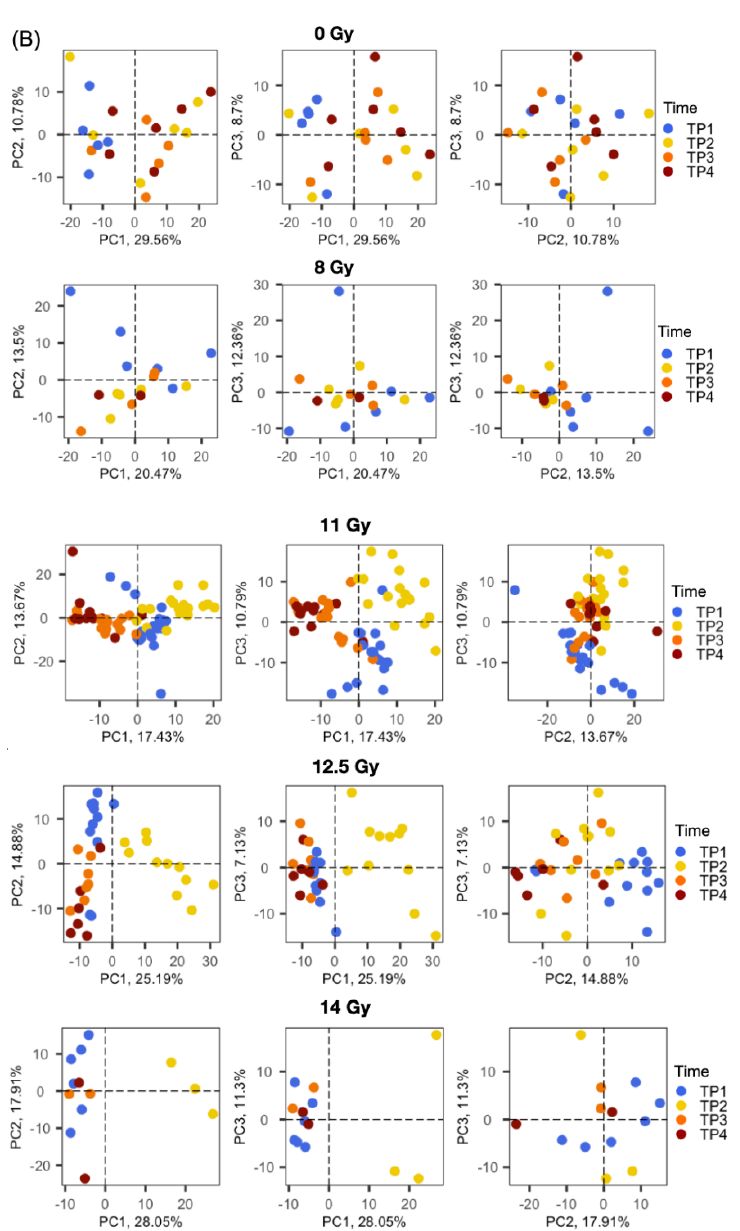
Figure 1. PCA plots. ( A ) comparison of radiation doses at different time points and ( B ) comparison of time points at different radiation doses. Overall, the highest segregation was observed for dose group 12.5 Gy and time group TP2. Note that only male samples were included in this PCA analysis. PC, principal component.